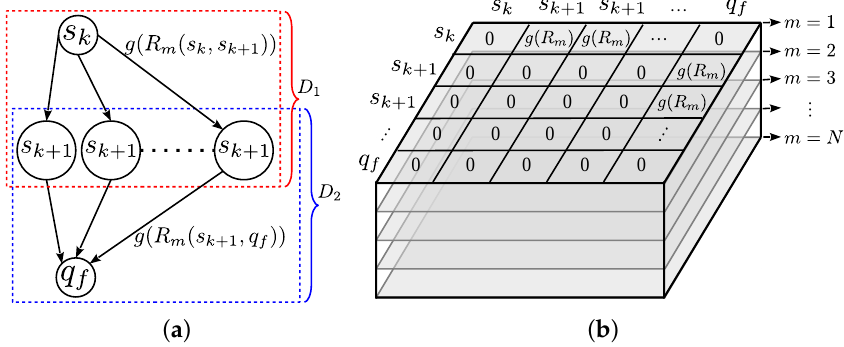
Figure 5. Generic structure state transition. ( a ) Generic state model. ( b ) Generic transition